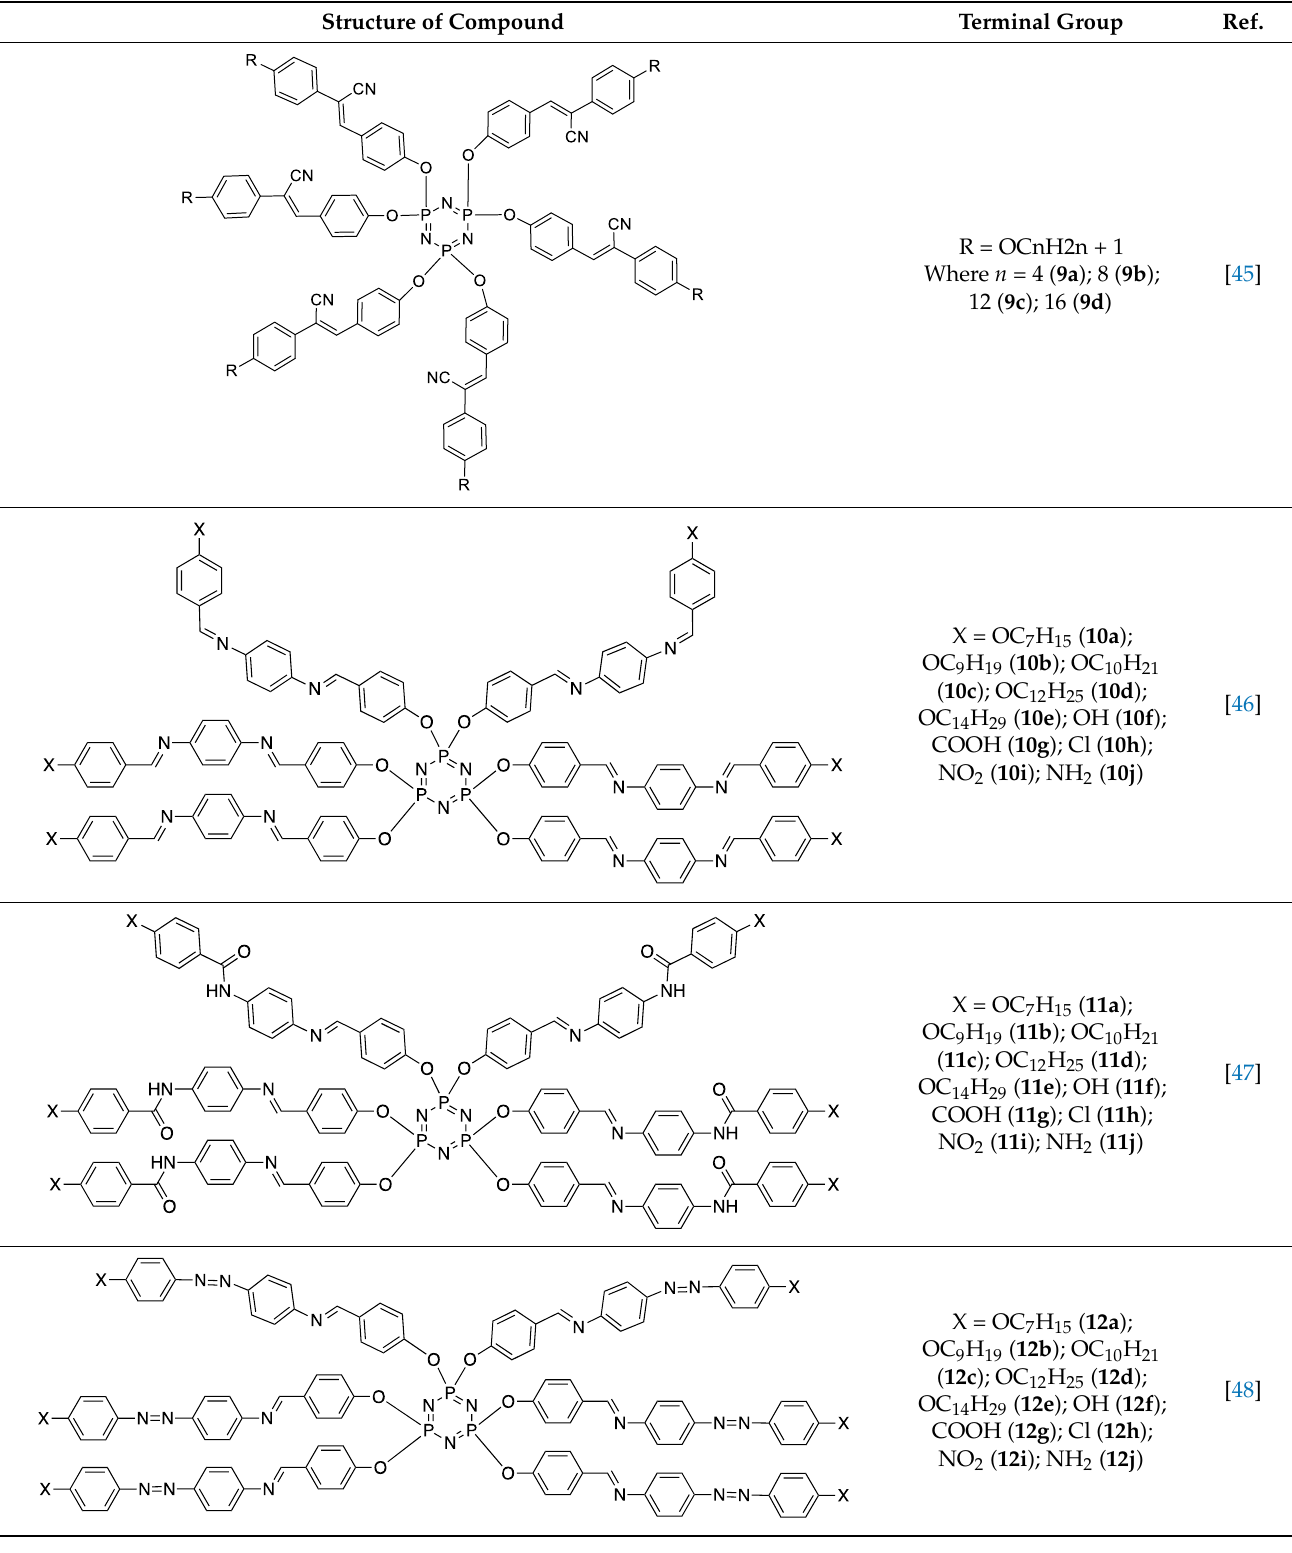
Table 5. Cont. Structure of Compound Terminal Group